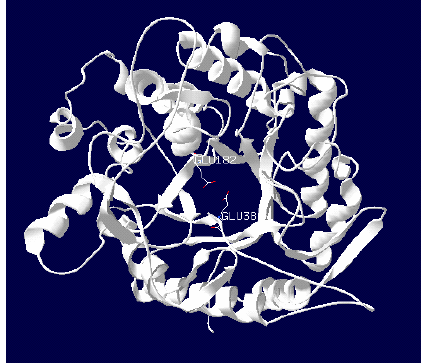
Figure 1. Molecular modeling of β -glucosidase deduced from bgl gene. Center for biological sequence analysis. http://www.cbs.dtu.dk/. CPHmodels 2.0: X3M a Computer Program to Extract 3D Models.